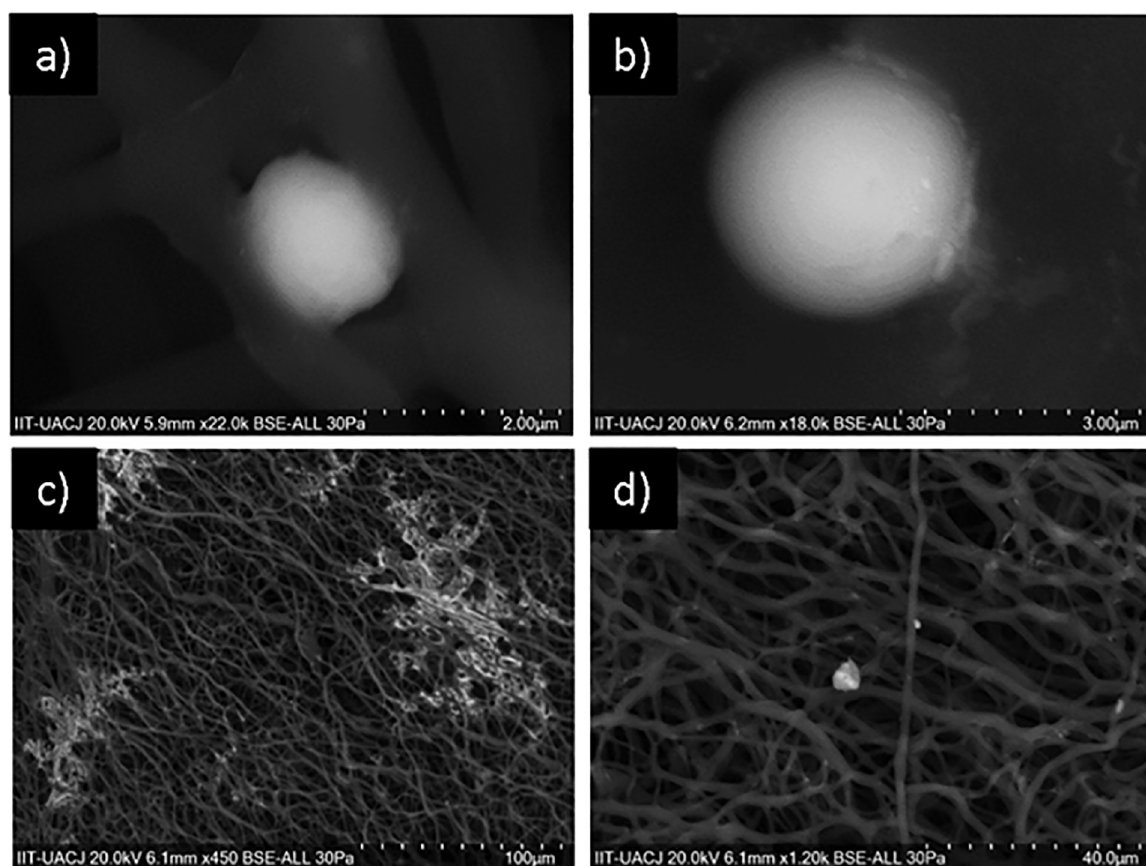
Fig 7. Inhibition effect of PCL-CuONPs against C. tropicalis. a) and b) are images of C . tropicalis exposed to plain PCL, and c) and d) are images C . tropicalis exposed to PCL-CuONPs at 200 mM.